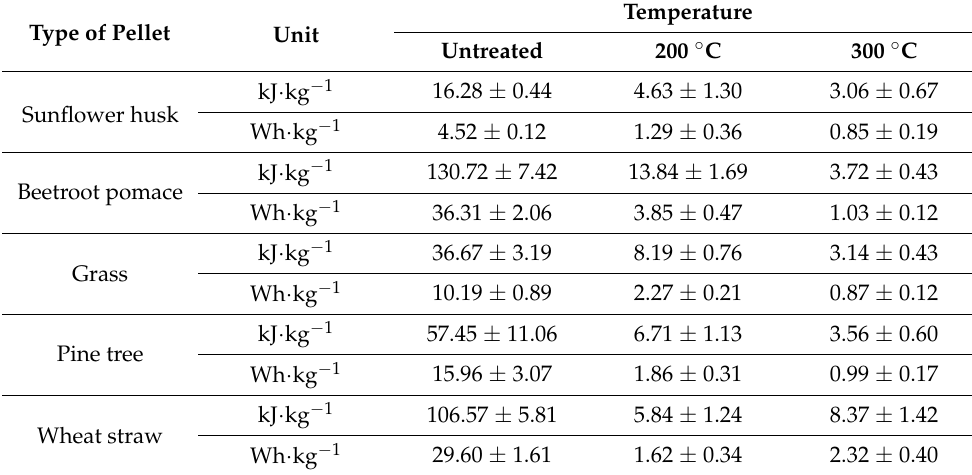
Table 4. Energy demand for grinding of the investigated